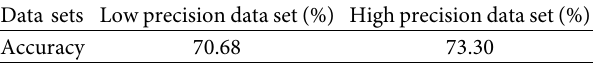
Table 5: Classification accuracy of Bayesian Logistic regression.